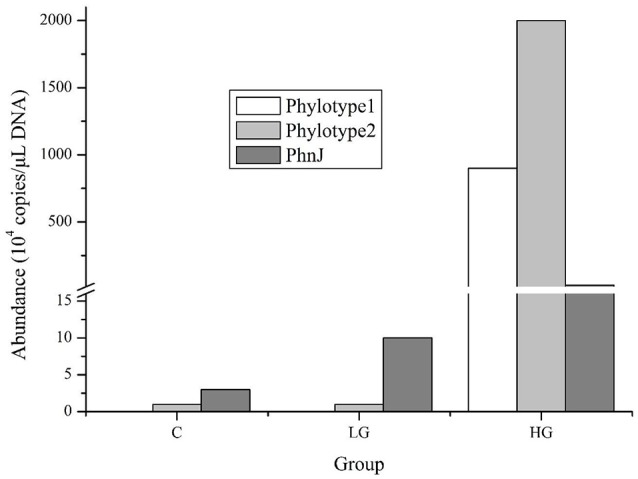
Abundance of two phylotype 16S rRNA genes and phnJ gene in different glyphosate treatment groups. In high-throughput sequencing libraries, phylotype 1 was only detected in group HG while phylotype 2 was detected in both LG and HG groups and its abundance increased orderly. The qPCR data for phnJ gene was generated from primers phnJF2 and phnJR2 shown in Table 2.